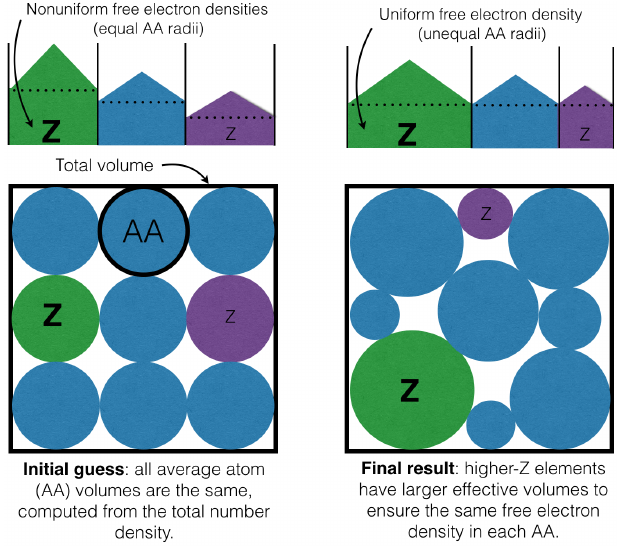
FIG. 13. Multispecies average-atom algorithm. Once an initial guess is chosen, Eqs. (A1) and (A4) are solved iteratively. Here, each atomic subvolume places pressure on the other subvolumes until the pressure equilibrates among the species. In the TF model, the pressure is obtained from the electronic density at the cell boundary, and pressure equilibrium is equivalent to exhibit- ing the same electronic density at the cell boundary. radii a α ¼ ð 4 π n α = 3 Þ − 1 = 3 . The mean ionization in each sphere is given functionally by ¯ Z (cid:3) α ¼ Z ð Z α ; v α ; T Þ ; e where T is the local electron temperature. The function e ¯ Z ð x Þ is the single-species mean-ionization function for are given plasma conditions x [63]. Note that Z α and T e given, and there is one equation of type (A1) for each species; however, we do not yet know the subvolumes v α (or, equivalently, the ion-sphere radii a α ).